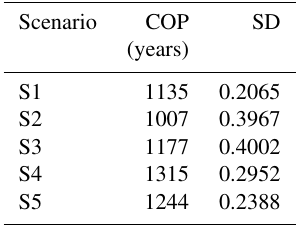
Table 3. Cut-off periods (COPs) and SD values used for creating the smooth synthetic temperature scenarios according to the Monte Carlo